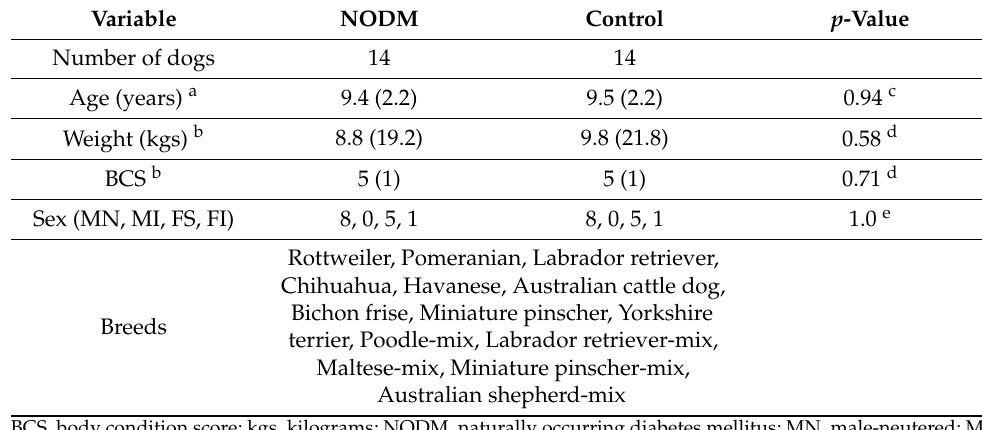
Table 1. Baseline descriptive characteristics in dogs with naturally occurring diabetes mellitus and non-diabetic healthy controls.